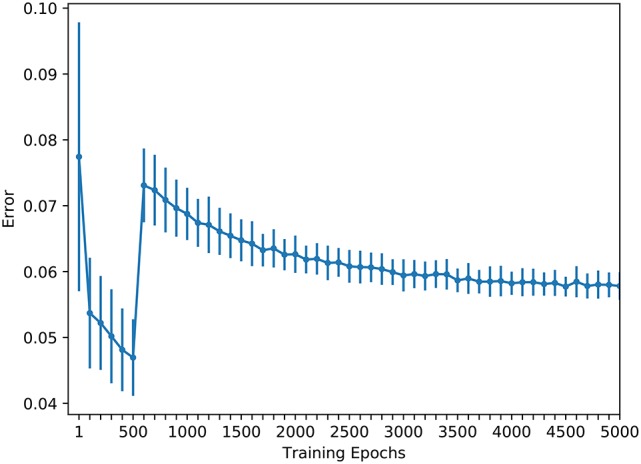
The training of the hand-eye coordination network.